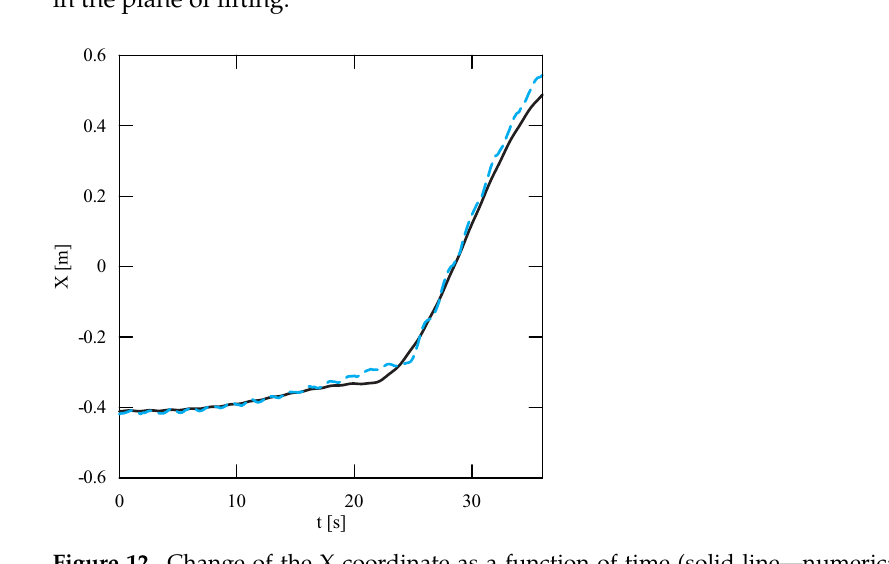
Figure 12. Change of the X coordinate as a function of time (solid line—numerical calculations, dashed line—experiment